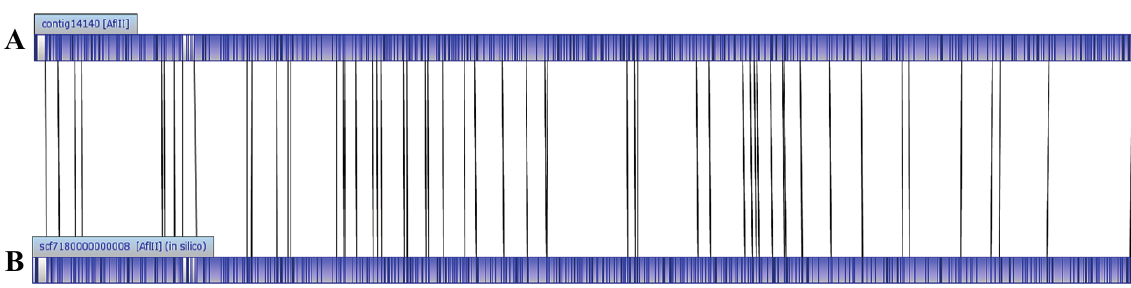
Figure 3. Circular representation of E. asburiae L1. The figure was constructed by ( A ) DNAPlotter version 1.4 and ( B ) Gepard version 1.3. The GC skew was shown in the most inner layer while the GC plot was shown in the second lane counting from the outer most lane. The genome size of E. asburiae L1 was 4.5 Mbp. The straight line of